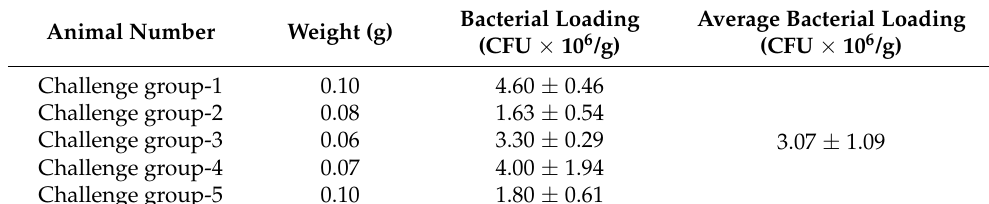
Figure 1. Mice and spleens, respectively, in challenge group ( A , C ) and control group ( B , D ). ( A ) Mouse showed depression and conjunctivitis. ( B ) Control group mice showed no symptoms. ( C ) Mouse spleen turned black, showing hyperemia and swelling. ( D ) Spleen in control group showed no pathological changes.